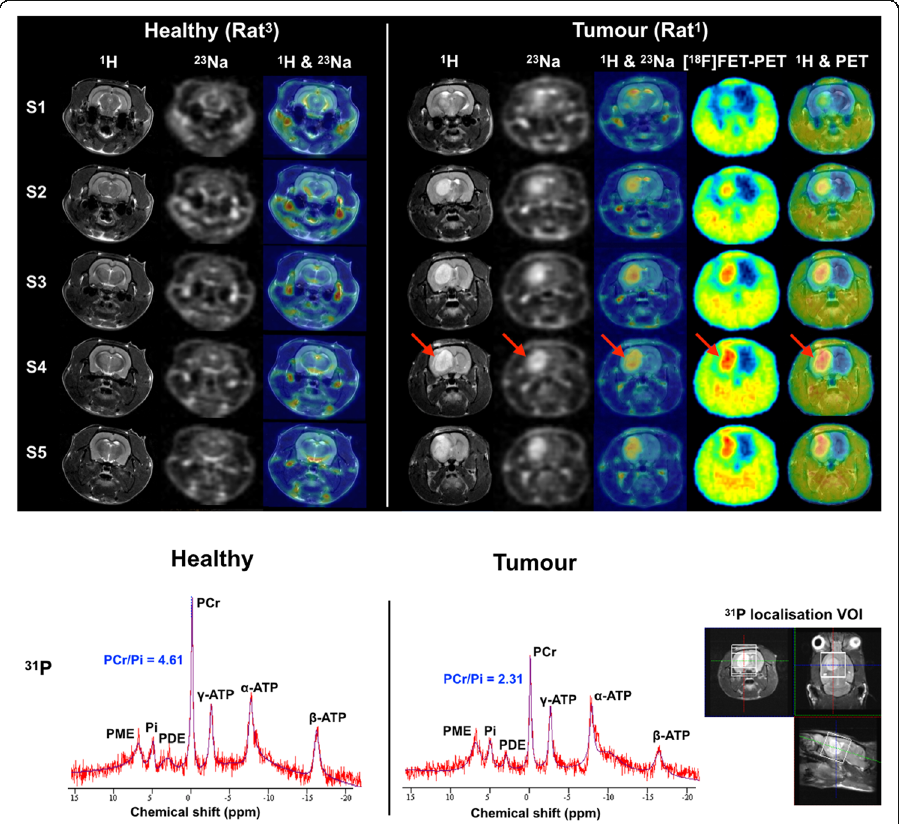
Fig. 2 Multinuclear 1 H MR, 23 Na MR and [ 18 F]FET-PET images (top) and 31 P spectra with fitting (bottom) of healthy (left, rat 3 ) and tumour-bearing (right, pointed out by the red arrow, rat 1 ) in vivo rat brain. S1-5, PME, PDE and VOI denote axial slice numbers of the rat brain, phosphomonoester (PME), phosphodiester (PDE) and voxel-of-interest (VOI),